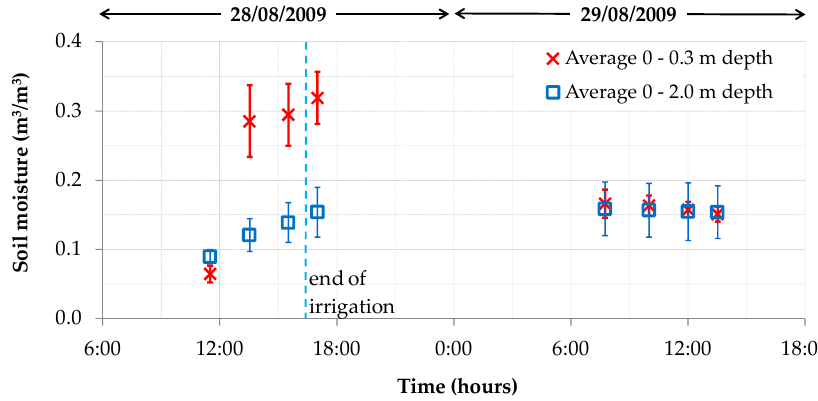
Figure 12. Grugliasco site, August 2009. Moisture contents and their standard deviation at different times after irrigation, computed from TDR measurements.